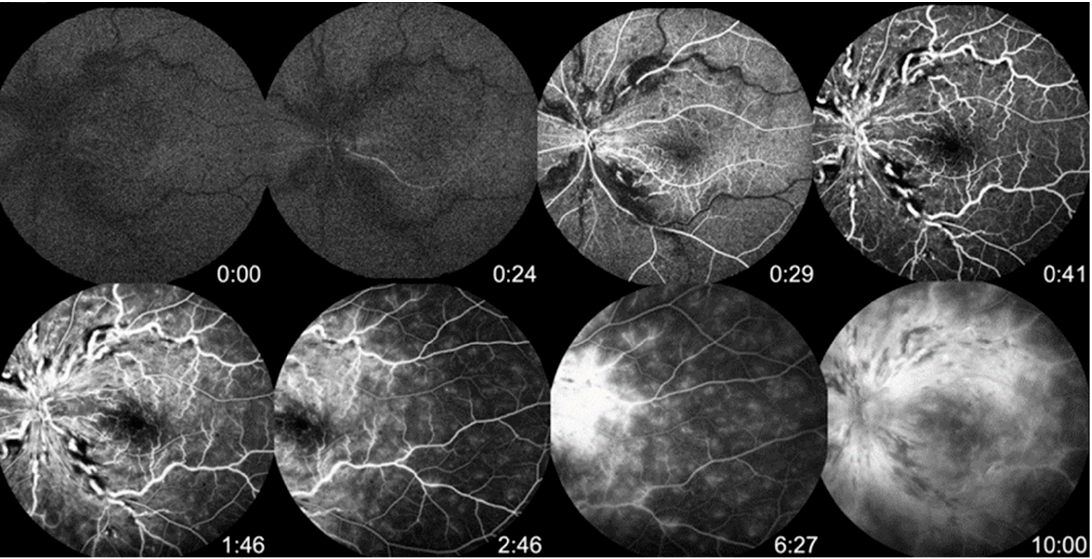
Figure 2. Fluorescein angiography (FA) of the left eye showed delayed arterial phase and arteriovenous transit time without significant ischemic areas in the retina.